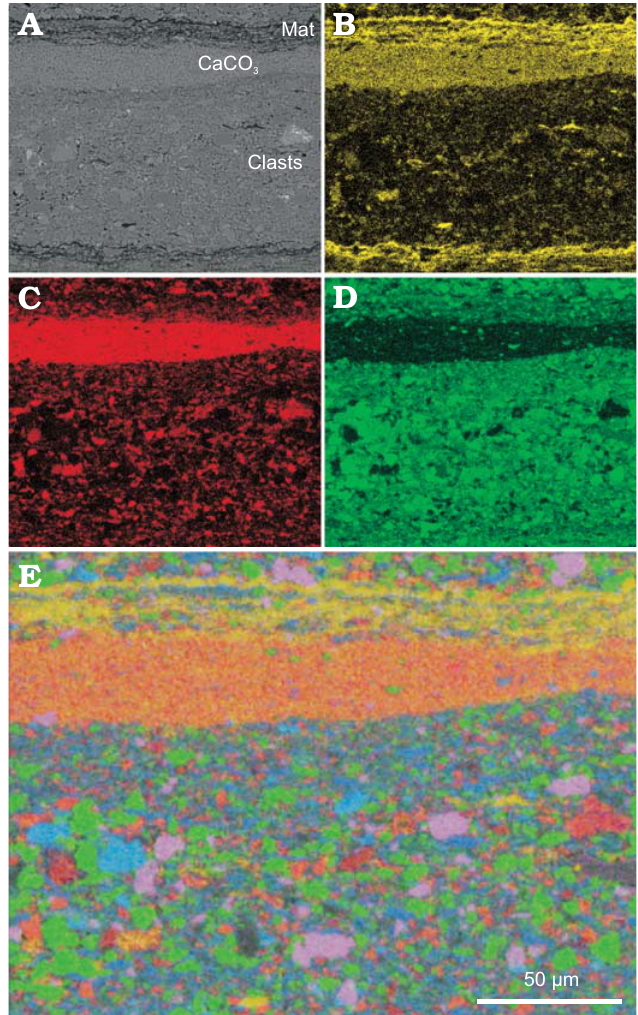
laminae.Fig. 6. Energy dispersive spectroscopy X-ray ion image maps of individ- ual elements within a single rhythmite from the Coal Creek member of the Kishenehn Formation, Eocene, Montana, USA. A . A scanning electron micrograph of a cross-section of a single rhythmite showing the mat, cal- cite (CaCO ) and siliciclastic (clastic) layers. B – D . X-ray ion image maps 3 of the elements carbon, calcium and silica respectively. E . A composite ion image energy dispersive X-ray map showing the localization of the elements carbon (yellow), calcium (red), silica (green), potassium (blue), and sodium (pink). The large blue crystals are potassium feldspar, the pink crystals are sodium feldspar and the green crystals are